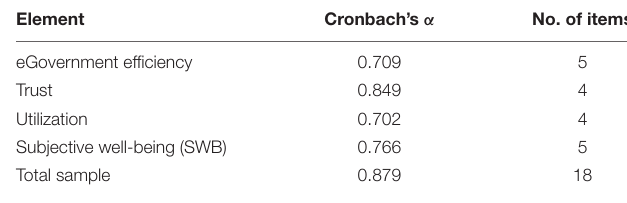
TABLE 1 | Results of the reliability analysis.